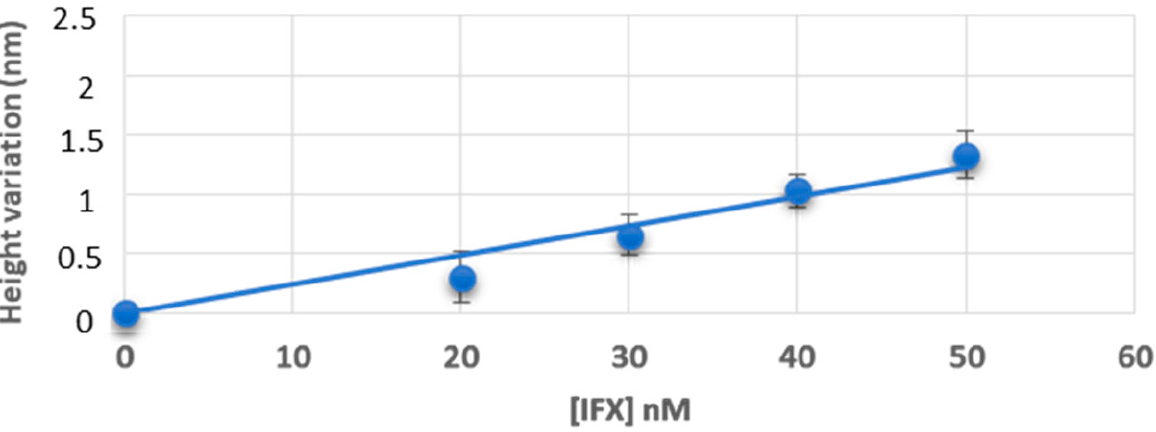
Figure 2. Calibration obtained in buffer. [IFX] = concentration of infliximab. Data are represented as mean ± standard deviation of three different measurements.